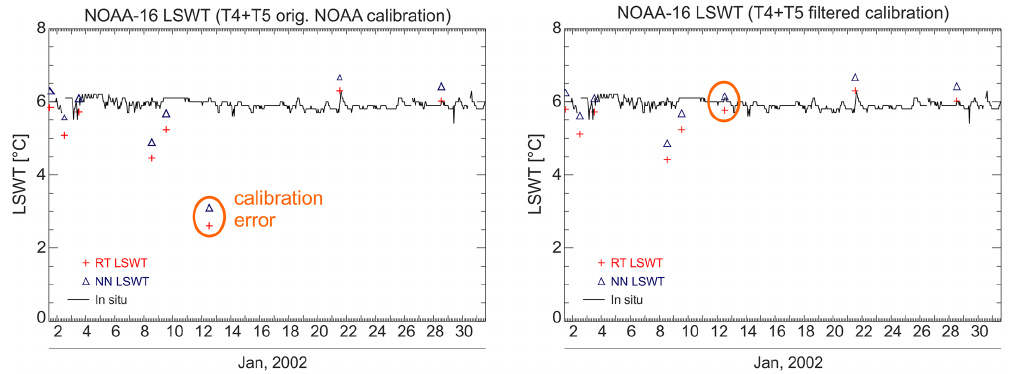
Figure 4. Comparison of lake temperatures measured in situ (solid line) and retrieved from satellite (symbols) by employing the original (left, Goodrum et al., 1999) and adjusted (right, Trishchenko, 2002) calibration methods to NOAA-16 AVHRR data in January 2002. RT and NN stand for the RTTOV-10 and NOAA NESDIS based retrieval of lake surface water temperature (LSWT), respectively. Encircled in orange is a case for which the sensor signal has been corrupted during the on-board calibration